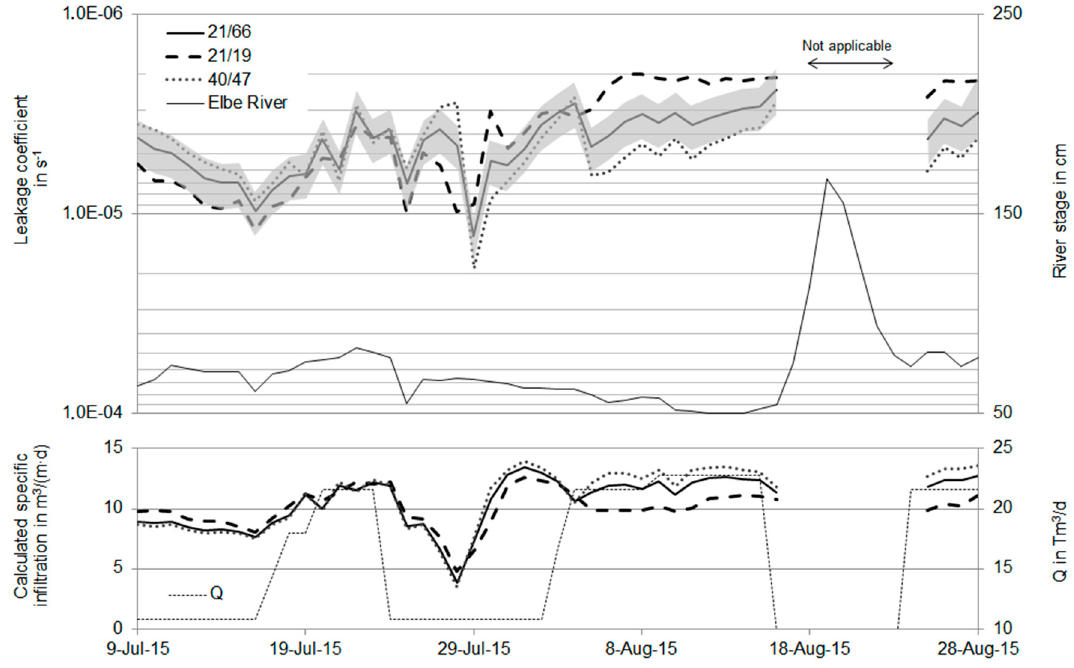
Figure 7. Temporal variations in L calculated for different MW ‐ separation distances at transect II, grey zone marks ±25% from 21/66.